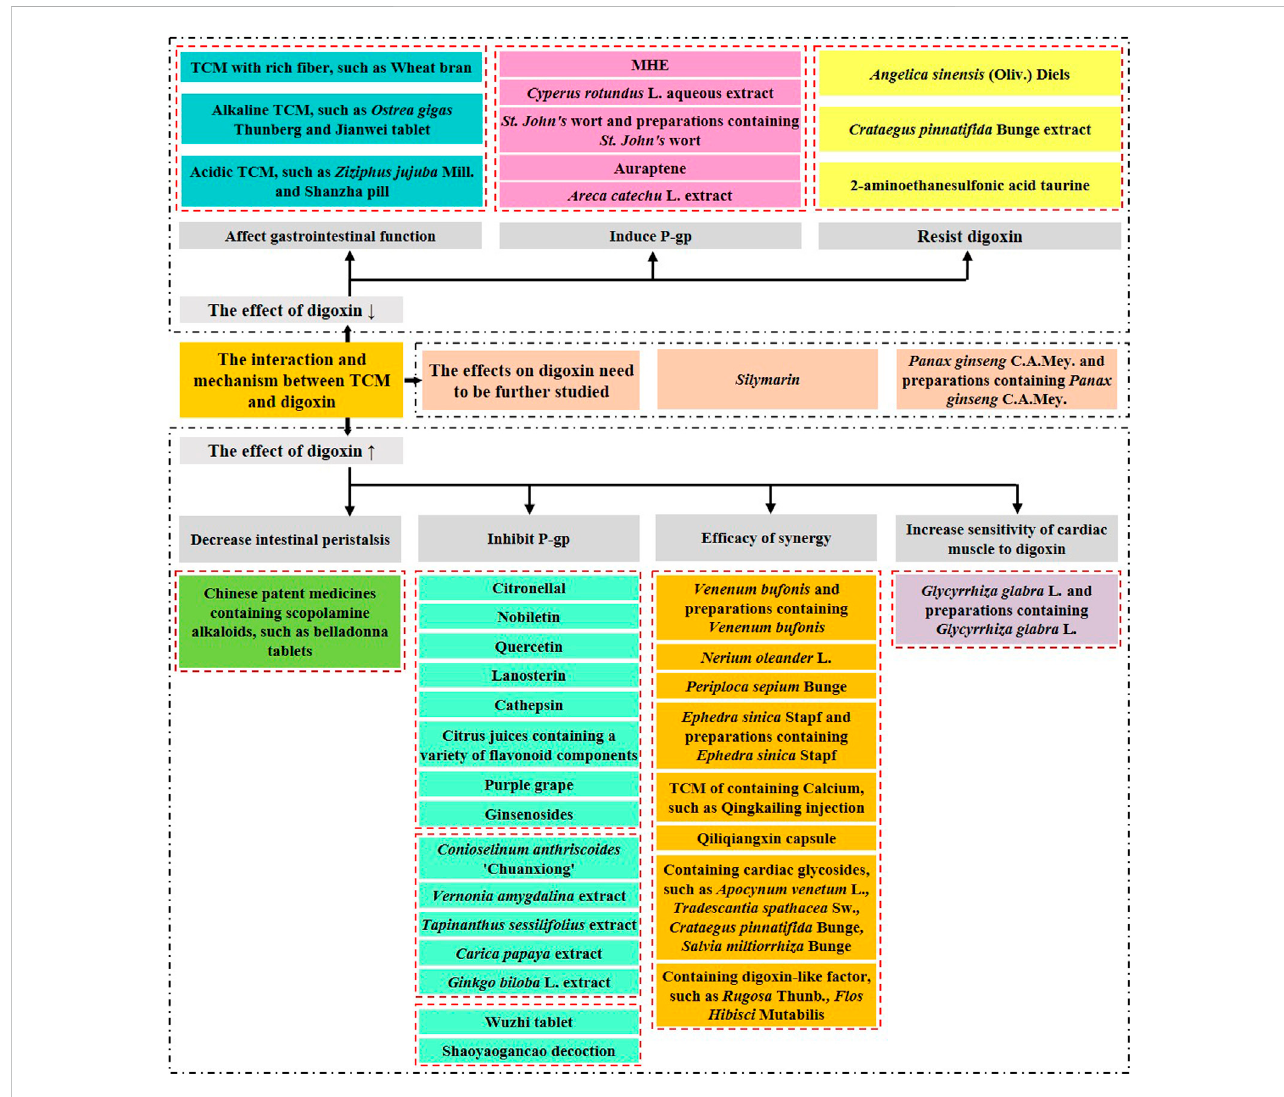
FIGURE 2 Interactions between TCM formulations and